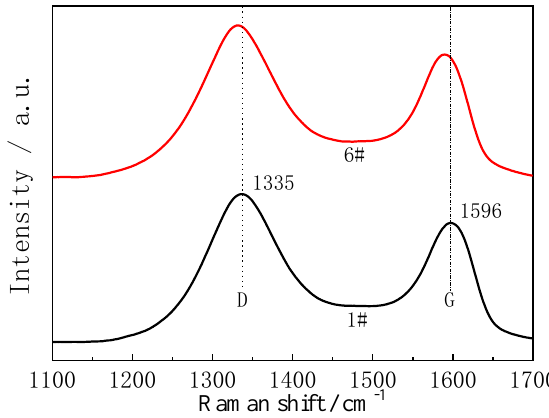
Figure 3. Raman spectra of catalysts 1# and 6#.